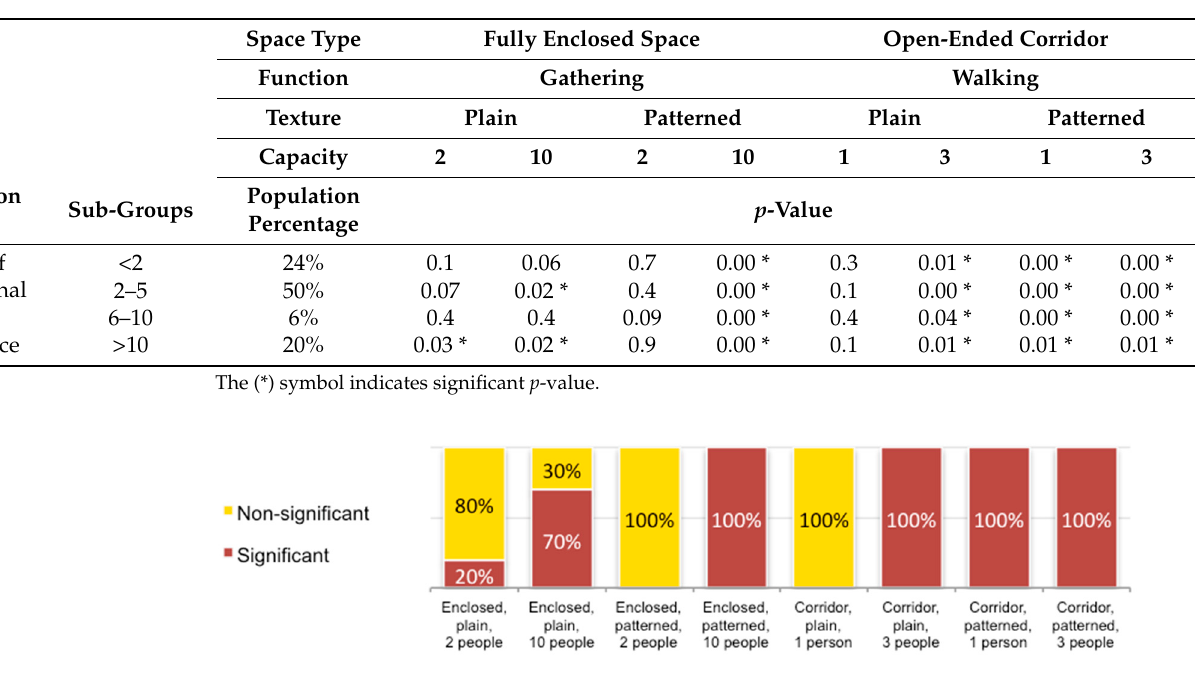
Figure 9. Percentage of participants with significant/non-significant size variations for each space in period of professional design experience perception filter.